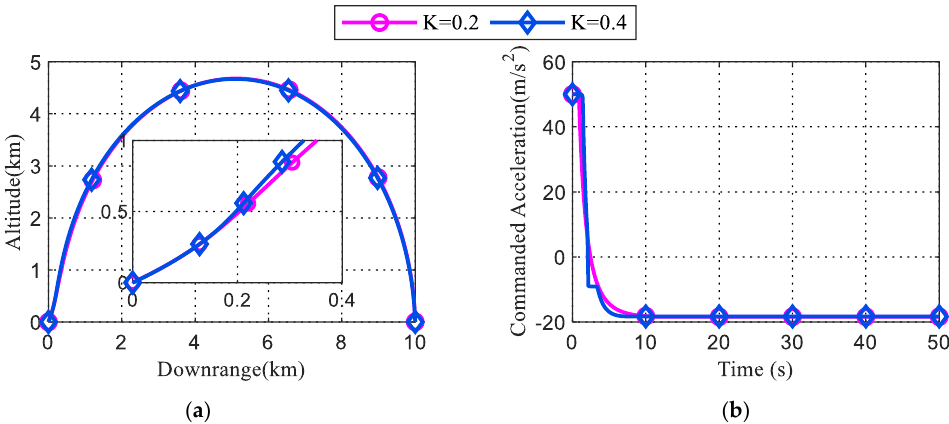
T 50 s. ( a ) Trajectories; ( b ) Lateral acceler-